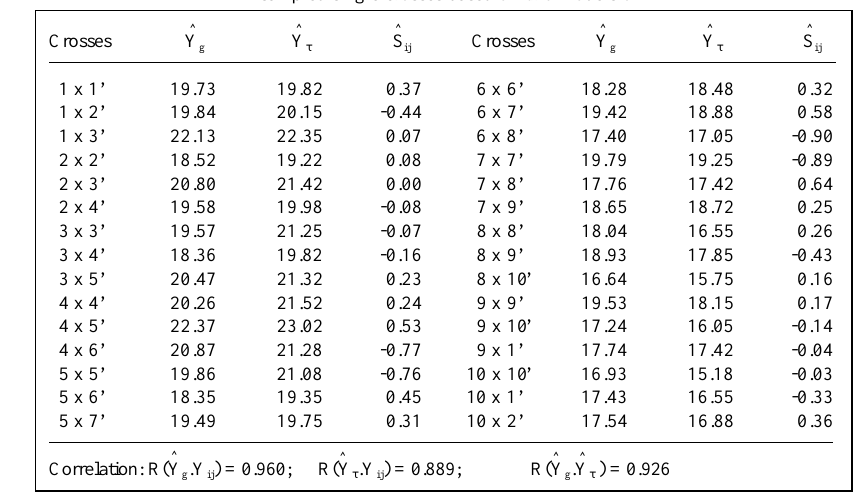
) and predicted means of ij